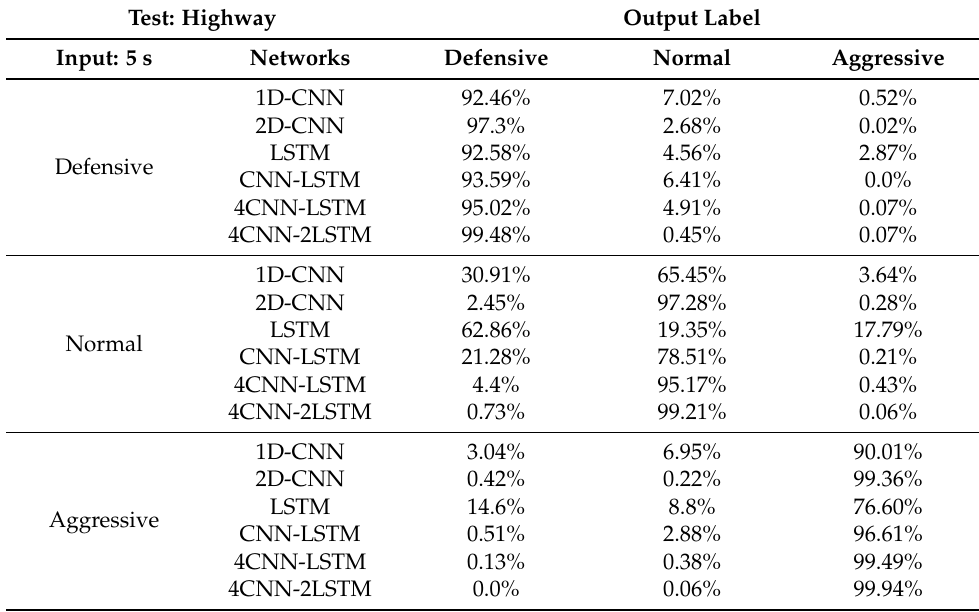
Table 8. Confusion matrix of highway driving behavior classification results in